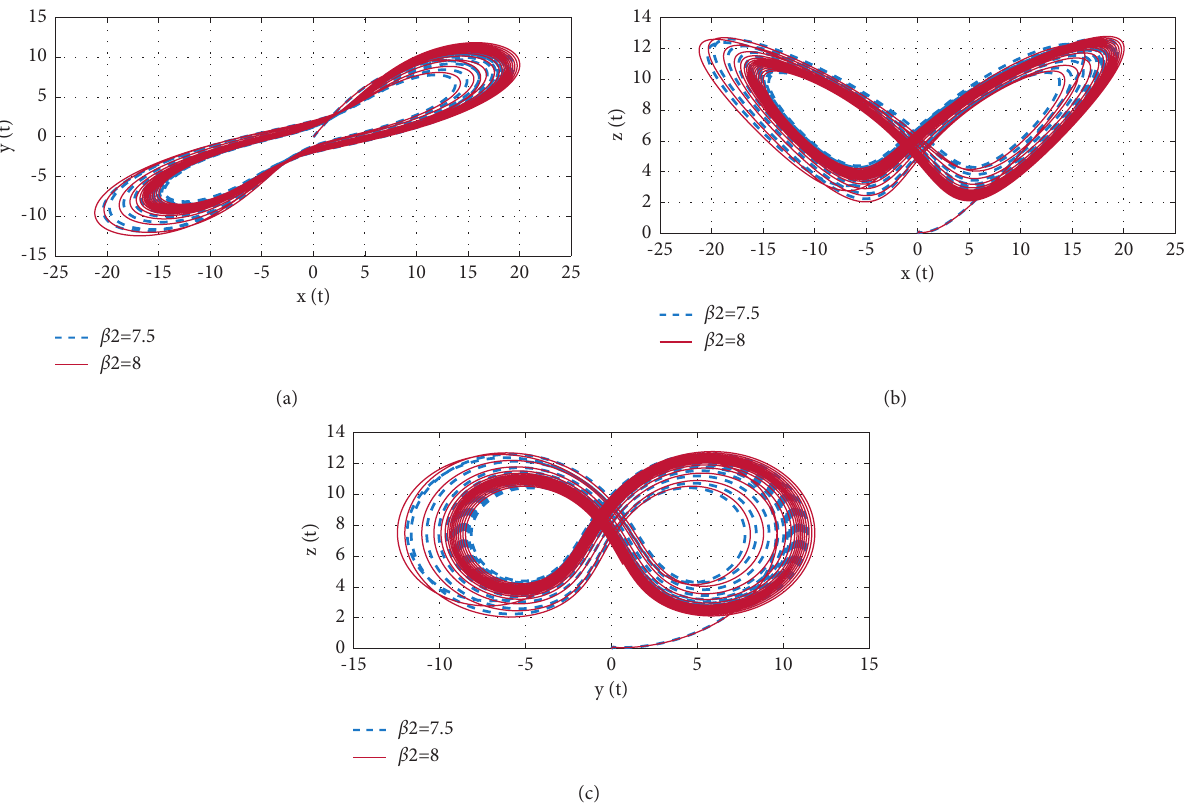
Figure 7: Phase portraits of the system (25) for different values parameter of β